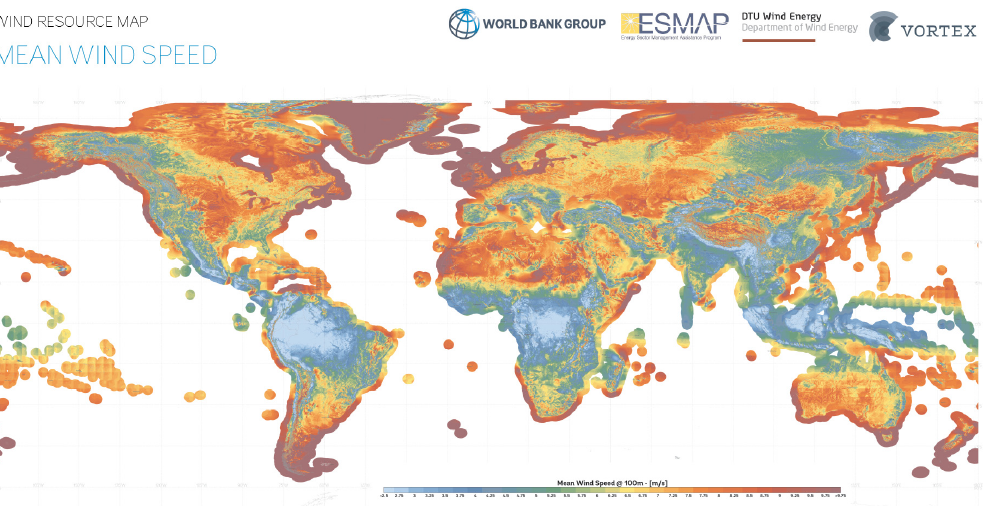
Figure 4. Wind energy potential worldwide (mean wind speed) [19]. Note: Map obtained from the Global Wind Atlas 3.0, a free, web-based application developed, owned and operated by the Technical University of Denmark (DTU). The Global Wind Atlas 3.0 is released in partnership with the World Bank Group, utilizing data provided by Vortex, using funding provided by the Energy Sector Management Assistance Program (ESMAP). For additional information: https://globalwindatlas.info (accessed on 3 August